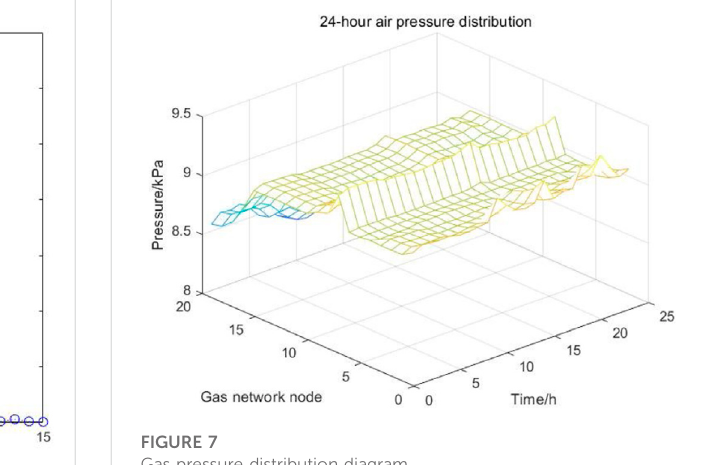
FIGURE 7 Gas pressure distribution diagram.